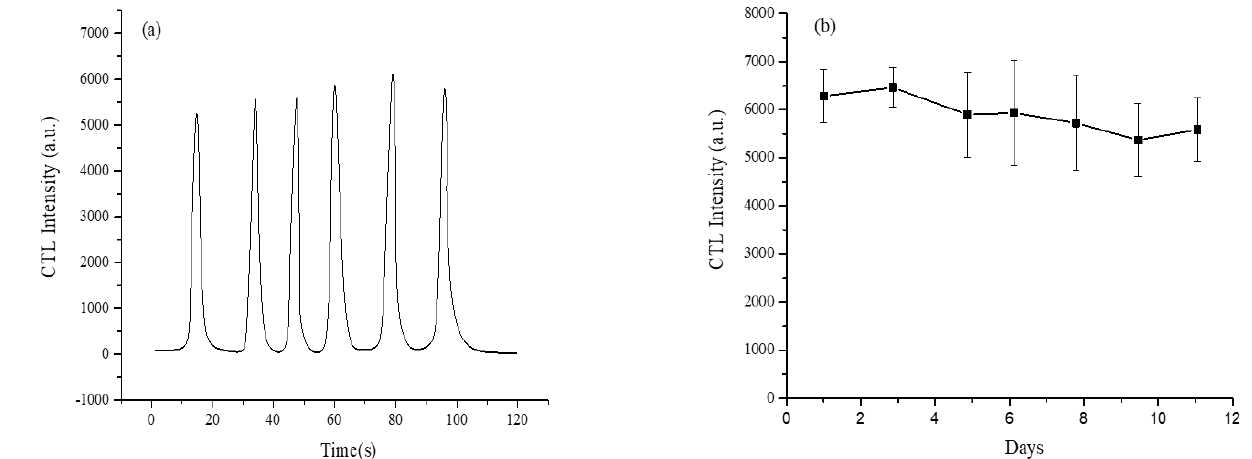
Figure 12. ( a ) Typical results obtained from six replicate determinations of acetone within 100 s. ( b ) The change trend of the luminescence intensity of acetone within one week (168 h). Flow rate: 310 mL/min, working temperature: 220 °C, wavelength: 590 nm, concentration: 900 ppm.